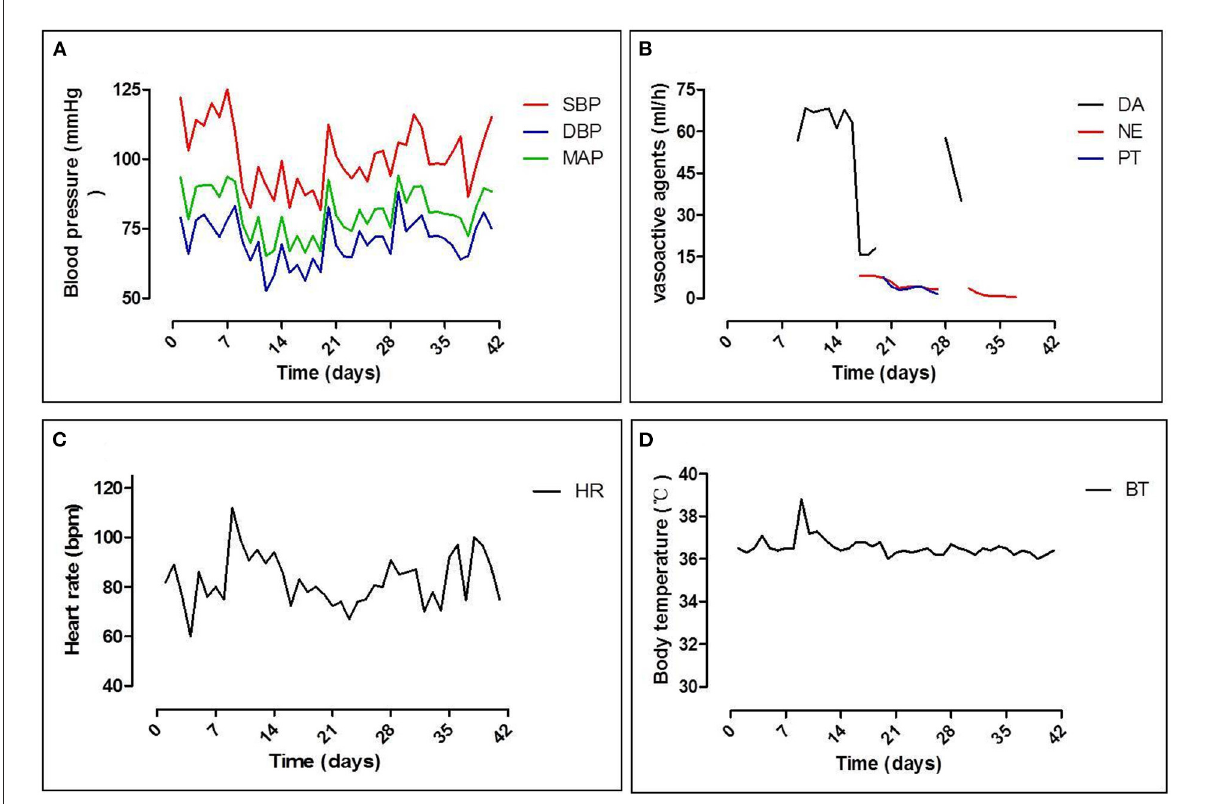
FIGURE3 Dynamic changes in vital signs. (A) Changes in systolic pressure (SBP), diastolic pressure (DBP), and mean arterial pressure (MAP); (B) vasoactive agents used during hypotension: dopamine (DA), norepinephrine (NE), and posterior pituitary hormone (PT); (C) changes in heart rate; and (D) body